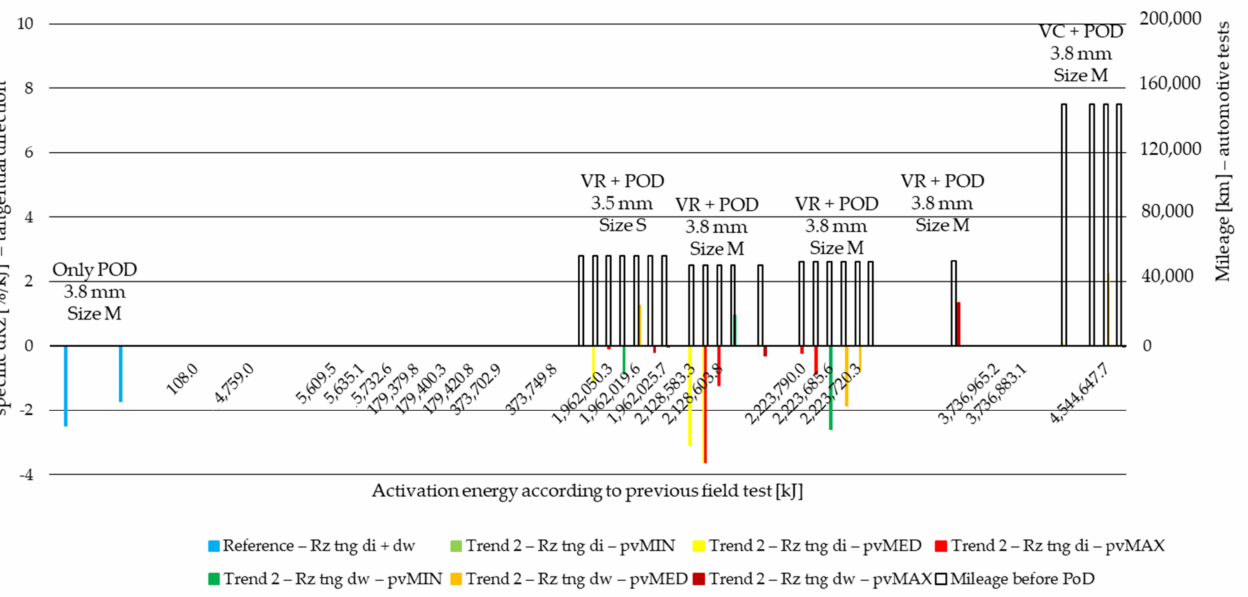
Figure A7. Tangential direction PoD specific Rz difference values of cut material samples from inner and working diameter after minimum, medium and maximum pv level pin-on-disc tests with previous field-test (Table 2) mileage along Joule scale—Trend 2: moderate load